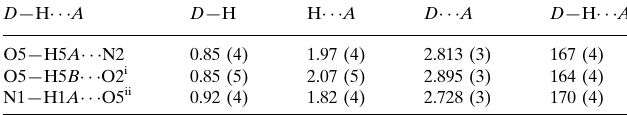
Hydrogen-bond geometry (A˚ , (cid:2)